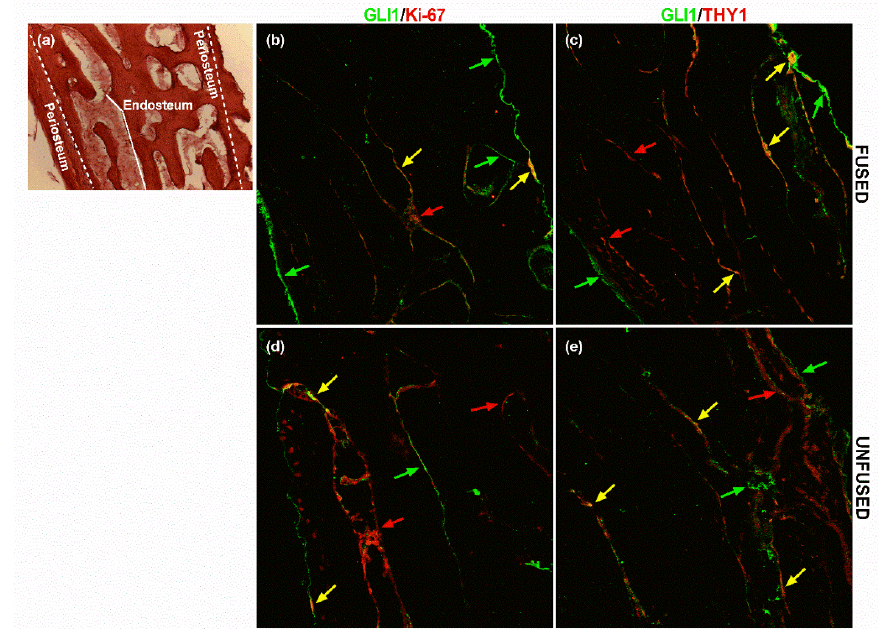
Figure 3. GLI1 and THY1 expression in calvarial bone. ( a ) The haematoxylin/eosin staining displays the histological structure of a cross-section of the flat calvarial bone, showing the periosteum and endosteum location. Localisation of GLI1/Ki-67 and GLI1/THY1 in ( b , c ) fused and ( d , e ) unfused suture tissue sections, assessed by immunofluorescence. Green arrows highlight cells GLI1+, red arrows point out ( b , d ) Ki-67+ cells and ( c , e ) THY1+ cells. Yellow arrows indicate GLI1+/THY1+ and GLI1+/Ki-67+ cells. The haematoxylin/eosin staining displays the histological structure of the flat calvarial bone. Pictures are representative of 90 microscopic fields from nine slides (technical replicates) at 20× magnification of three patients (biological replicates) (see Methods for details). 2.2. Expression of Calvarial Stem Cell Markers in Calvarial Mesenchymal Stromal Cells (CMSC) The expression of the selected marker genes THY1 , ITGAV , TEK , ENPEP , GLI1 and AXIN2 was analysed in calvarial MSC isolated both from physiologically patent sutures (termed “Normal”, N- CMSC) and from prematurely fused sutures (termed “Pathologic”, P-CMSC), using bone marrow MSC (BM-MSC) isolated from the iliac crest and grown in standard culture condition as “gold standard” osteogenic MSC controls. The expression of THY1 and ITGAV was comparable among the three tested cell types (Figure 4a,b), whereas the expression of TEK showed a reduced trend in CMSC compared with BM-MSC, although the differential expression levels reached statistical significance only in P-CMSC (Figure 4c). The expression of ENPEP showed an inverted trend, as it was significantly upregulated in P-CMSC over BM-MSC, with an increased trend also in N-CMSC over BM-MSC (no statistical significance; Figure 4d). GLI1 expression was significantly overexpressed over BM-MSC in both N- and P-CMSC (Figure 4e). Finally, AXIN2 was significantly overexpressed in N-CMSC compared with BM-MSC (Figure 4f). Interestingly, the expression of AXIN2 resulted significantly lower in P-CMSC over N-CMSC (Figure 4f).